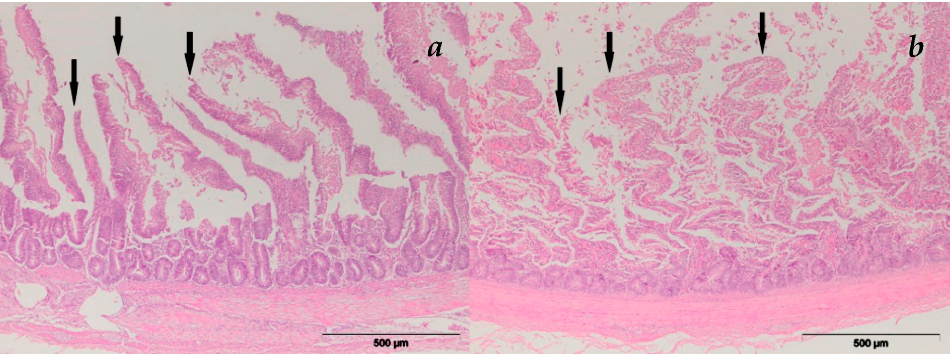
Figure 1. Intestinal villi atrophy by AFB1 and T‑2 toxin combination, HE staining: ( a ) group E‑V; ( b ) group E‑VI (with MR) .